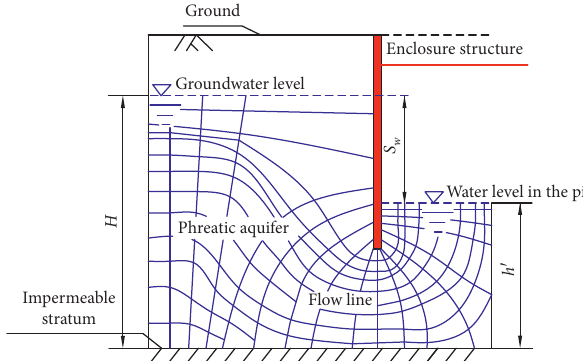
Figure 2: Seepage field distribution around a single-layered soil foundation